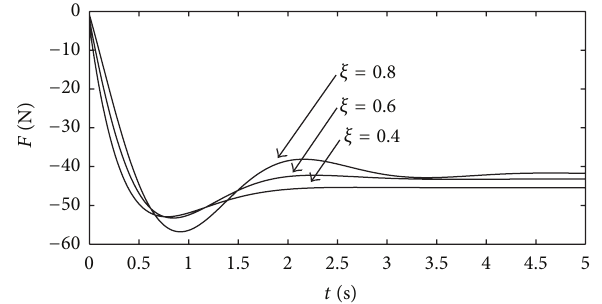
Figure 3: The influence of the damping coefficient on the dynamic tension ( 𝛼 = 0.4 , 𝑎 = 0.4 m / s): (a) 𝜉 = 0.4 ; (b) 𝜉 = 0.6 ; (c) 𝜉 = 0.8 .